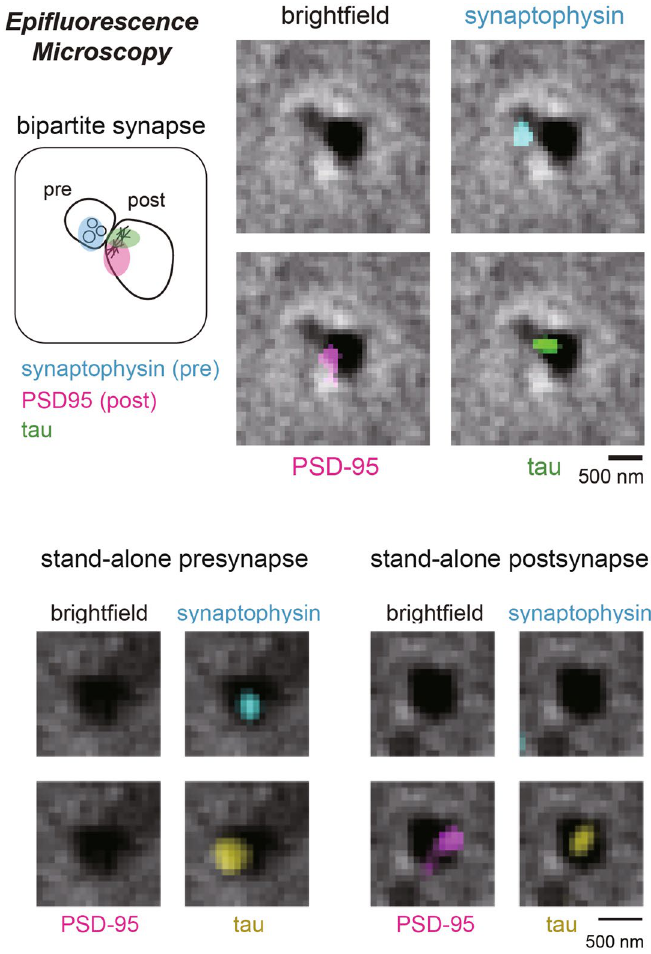
Figure 3. Epifluorescence images of a bipartite synapse immunostained against tau and presynaptic/ postsynaptic markers. Fluorescence signals are overlaid on top of the brightfield